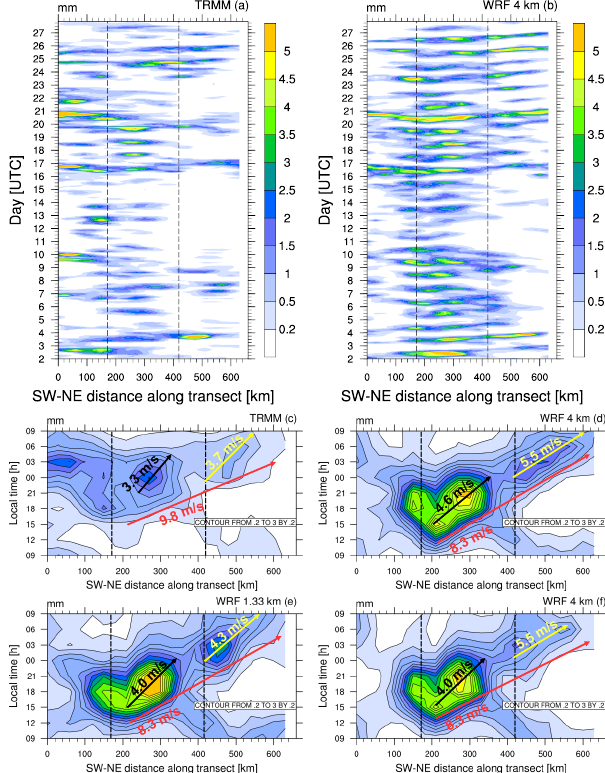
Figure 4. Time–distance plots of 3-hourly mean rainfall, averaged across the line sections in Fig. 1a, from (a) TRMM and (b) 4km WRF for the period 2–28 February 2010. The mean diurnal cycle in local time, composited using 3-hourly data, is also shown for (c) TRMM, (d) 4km (re-initialised runs), (e) 1.33km, and (f) 4km 2-week free-running WRF runs. Vertical dashed lines represent the positions of the averaged mountain peak (about 170km) and north- ern coastline (about 420km) respectively. Coloured lines show the estimated phase speeds for the peak rain signals over land (black), over water (yellow), and for the broader rain envelope